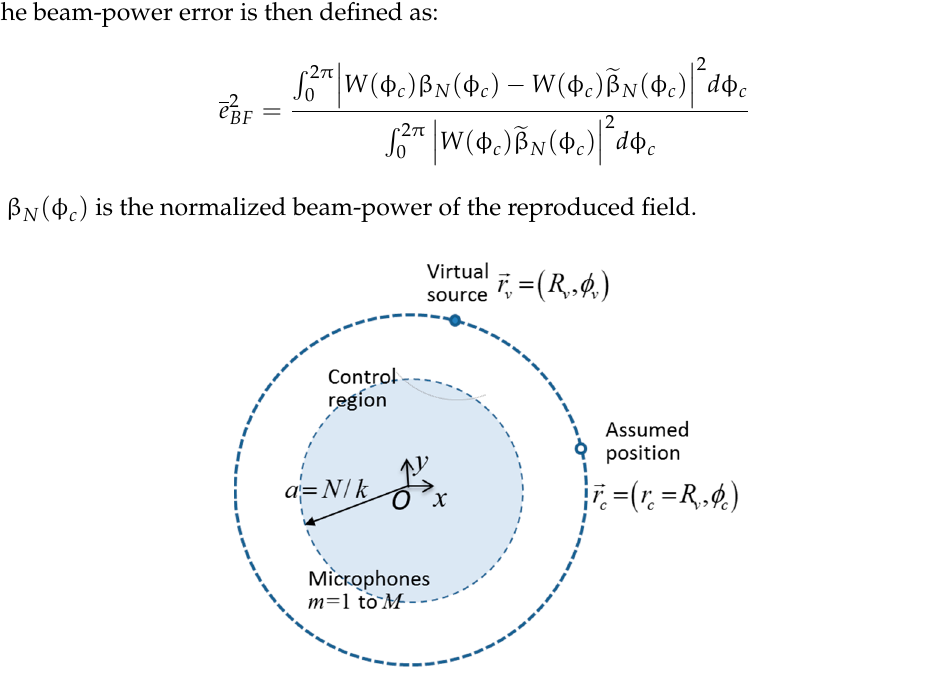
Figure 3 . Setup for the beamforming method of a simple example. Figure 3. Setup for the beamforming method of a simple